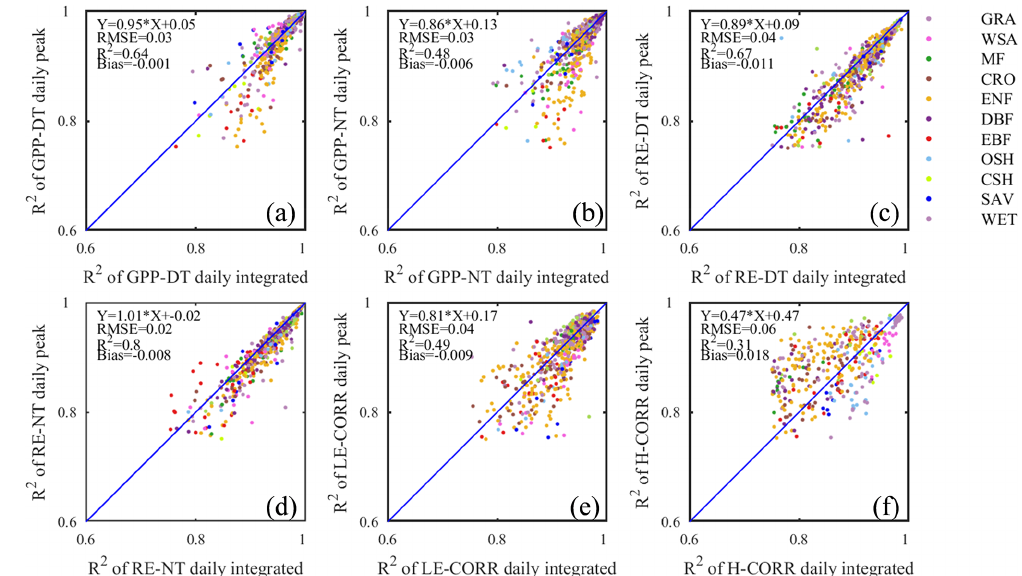
Figure 4. Comparison of the coefficients of determination ( R 2 ) of fitted seasonality curves between daily integrated fluxes ( x axis) and daily peak fluxes ( y axis) for GPP (a, b) , RE (c, d) , LE (e) , and H (f) . Both daytime (DT) and nighttime (NT) flux partitioning models are shown for GPP and RE.